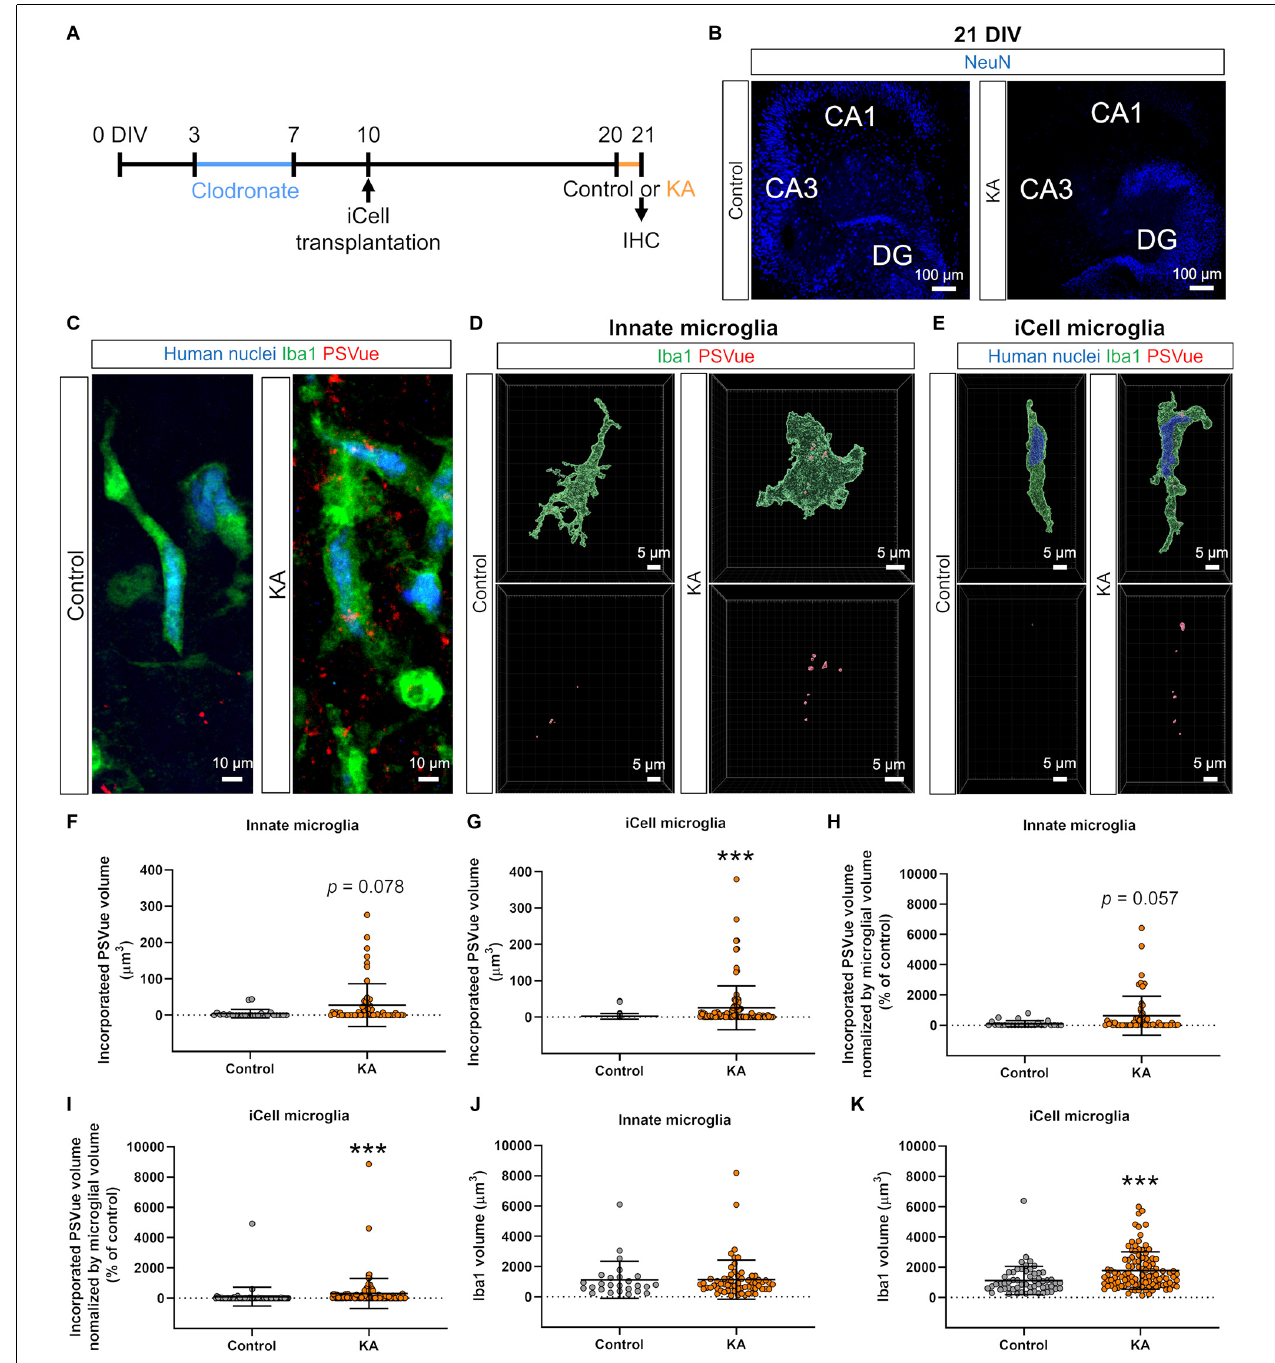
FIGURE 3 | Transplanted iCell-MG phagocytosed phosphatidylserine (PS). (A) Experimental paradigm. (B) Representative images of cultures immunostained for NeuN at 21 DIV (blue). Neuronal cell death was induced in CA3 and CA1 fields with kainic acid (KA). (C) Representative images of iCell-MG in the control (left) and KA groups (right) at 21 DIV. Cultures were immunostained with human nuclei (blue) and Iba1 (green) following PSVue staining (red). (D,E) Three-dimensional (3D) reconstruction of innate microglia (D) and iCell-MG (E) that incorporated PSVue in the control and KA-treated cultures. (F,G) Incorporated PSVue volume per microglia by innate microglia (F) and iCell-MG (G) . *** p < 0.001, Mann-Whitney rank sum test, n = 26 (innate microglia in control), 58 (innate microglia in KA), 63 (iCell-MG in control), and 107 (iCell-MG in KA) cells, from six (control) and 10 (KA) slices, from four (control and KA) mice. Data represent the mean ± SD. (H,I) Incorporated PS volume per microglial volume by innate microglia (H) and iCell-MG (I) . *** p < 0.001, Mann-Whitney rank sum test, n = 26 (innate microglia in control), 58 (innate microglia in KA), 63 (iCell-MG in control), and 107 (iCell-MG in KA) cells, from six (control) and 10 (KA) slices, from four (control and KA) mice. (J,K) Innate microglial volume (J) and iCell-MG (K) . *** p < 0.001, Mann-Whitney rank sum test, n = 26 (innate microglia in control), 58 (innate microglia in KA), 63 (iCell-MG in control), and 107 (iCell-MG in KA) cells, from six (control) and 10 (KA) slices, from four (control and KA) mice. Data represent the mean ± SD.